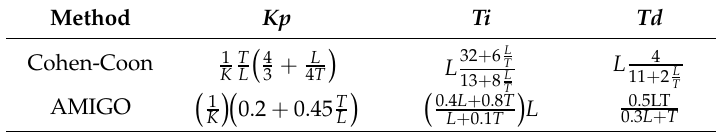
Figure 6. TCLab open-loop step response ( top plot ) and particle swarm optimization (PSO) model step response overlapped with the real TCLab data ( bottom plot ). Table 1. Cohen-Coon [32] and AMIGO [5] proportional, integral, and derivative (PID) tuning rules.